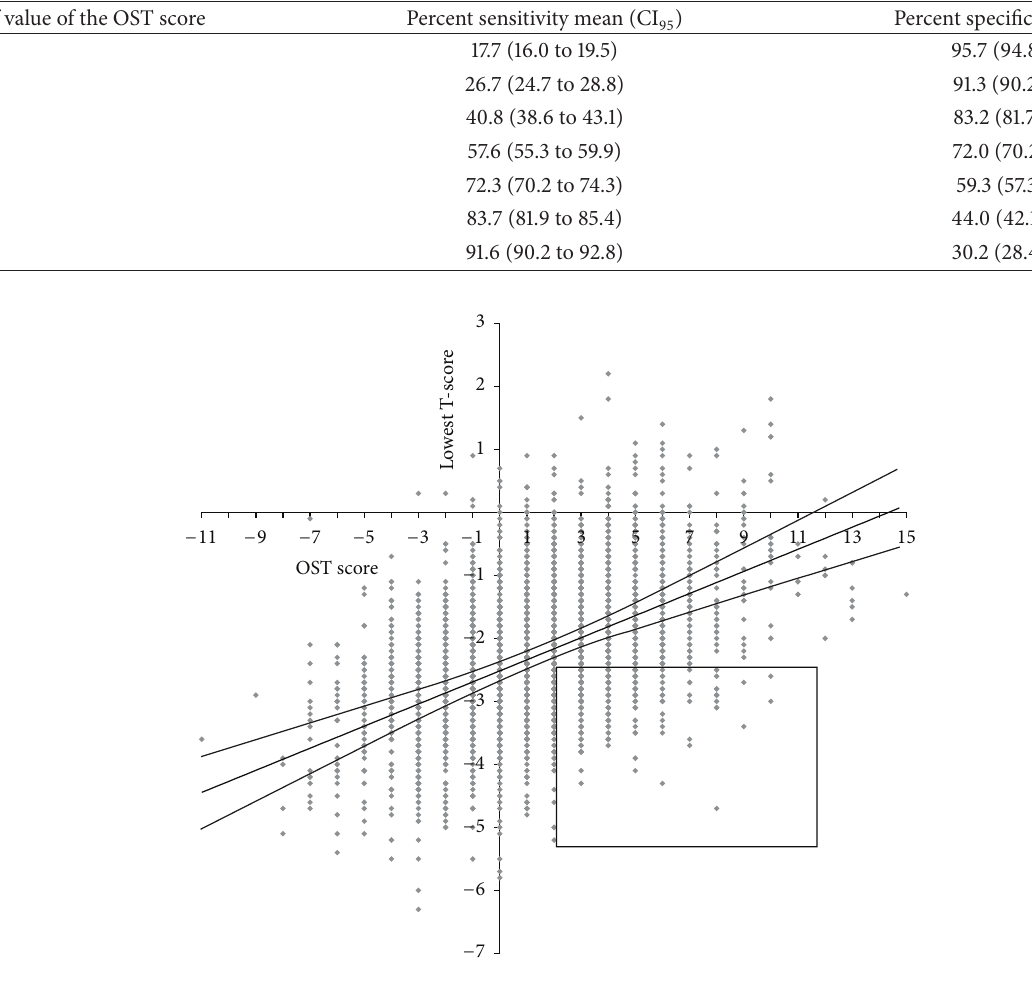
Figure 2: A plot of the OST score versus the lowest T-score (at any site). There is a significant linear relationship between both scores ( 𝑅 = 0.114 ; 𝑃 < 0.0001 ). The rectangle highlights the patients with T-scores at −2.5 or below who had OST scores above 2 ( 𝑁 = 298